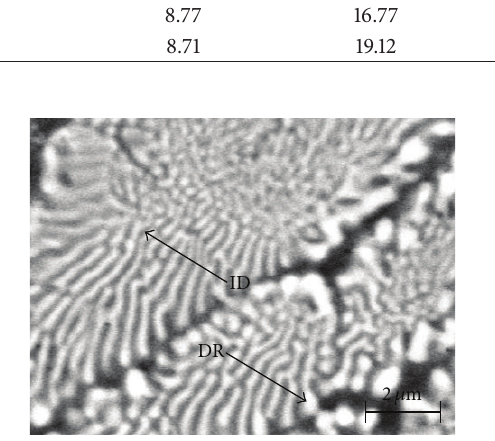
Figure 3: Microstructure of the surface of CoCrFeMnNbNi HEA coating.